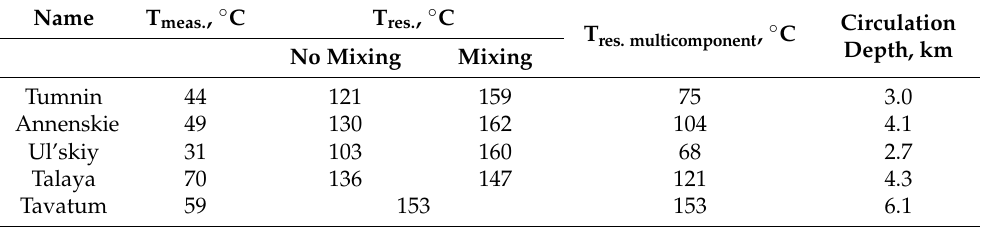
Table 4. Reservoir temperature and circulation depth the studied thermal